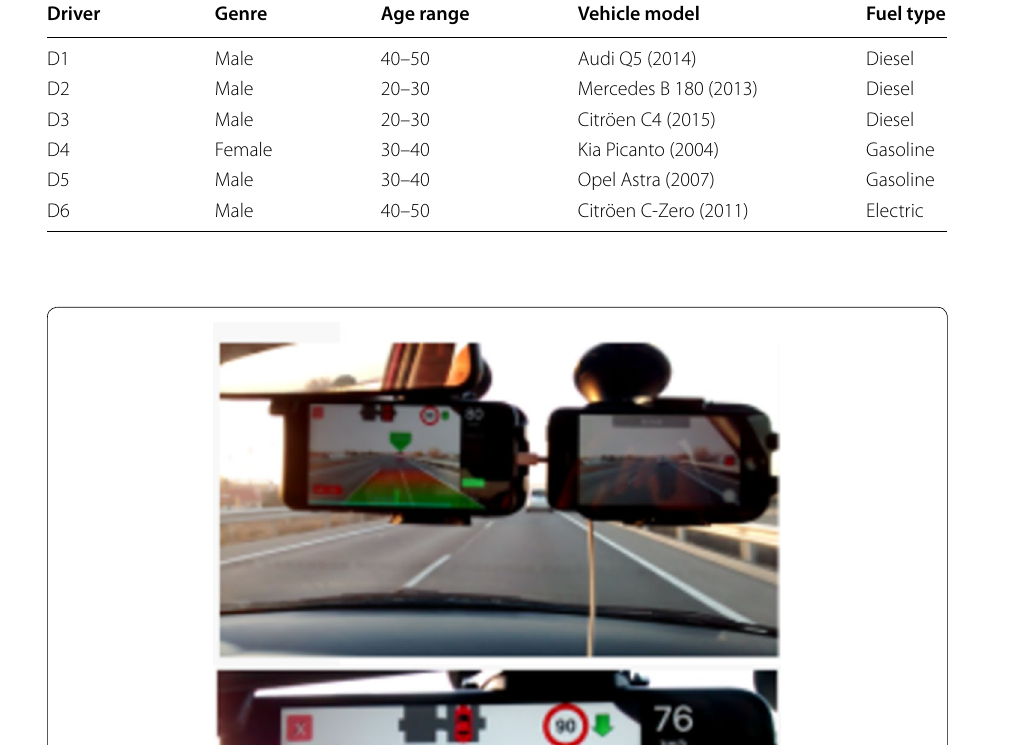
Table 2 List of drivers and vehicle that performed the tests (UAH-Driveset) Driver